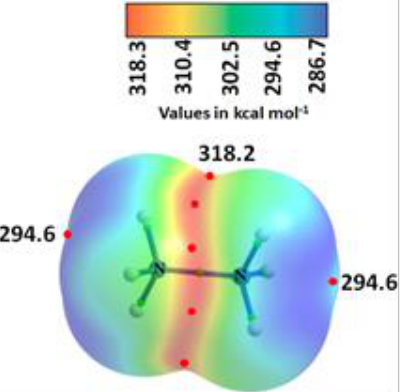
Figure 2. MP2/Aug-cc-pVTZ level 0.001 a.u. (electrons Bohr −3 ) isoelectron density envelope mapped potential on the electrostatic surface of [NH 3 NH 3 ] 2+ . There is no local most minima ( V S , min ), but only local most maxima V S , max (tiny red circles) identified on the surface of the two N atoms along N–N covalent bond extensions and around the central bonding region of the same